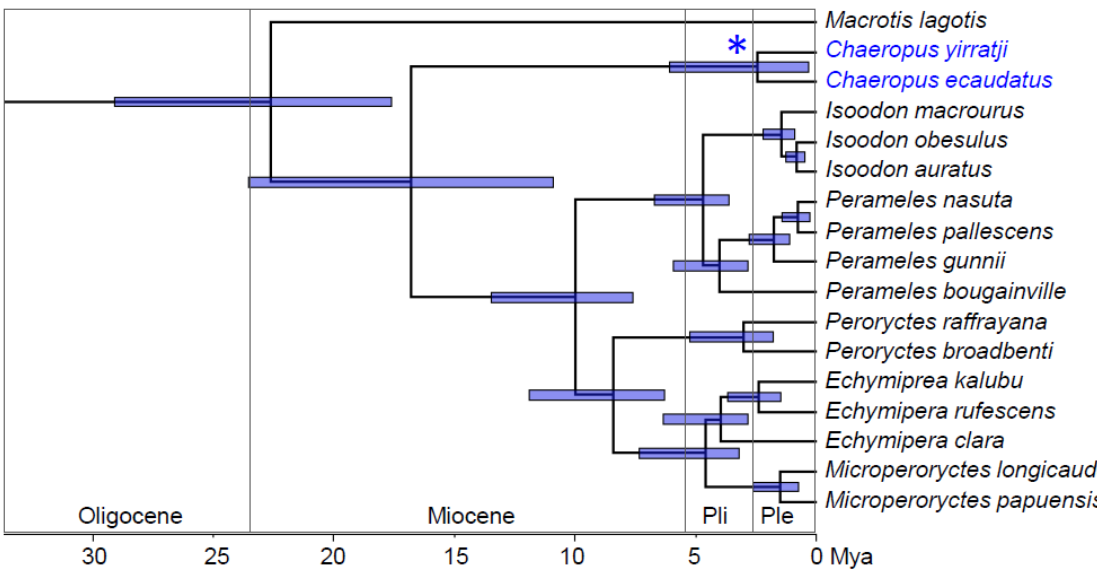
Figure 5. Molecular dated evolutionary timescale for peramelemorphian evolution, inferred in BEAST on the MtNuc 26 data matrix with Cytb 3rd codon positions RY coded. Blue bars show 95% highest posterior density for node ages. The asterisk indicates the approximate age of Chaeropus baynesi from the Fisherman’s Cliff Local Fauna. Outgroup taxa and divergence times are provided in the Supplementary Information. Abbreviations: Pli; Pliocene, Ple; Pleistocene.